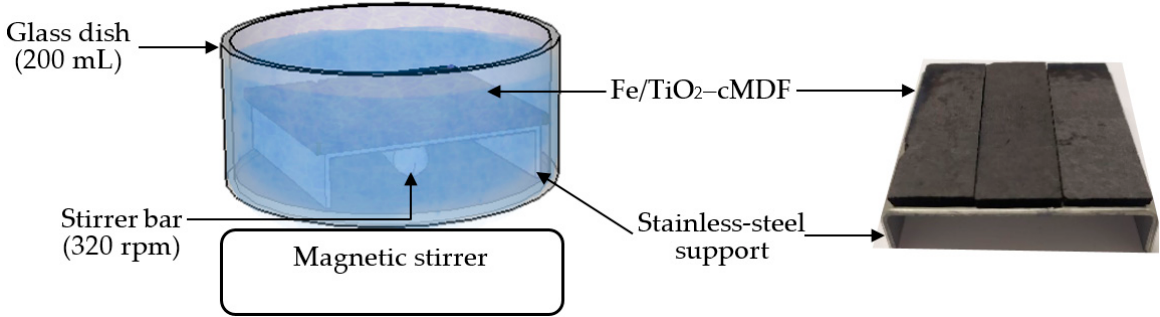
Figure 2. Representation of the adsorption